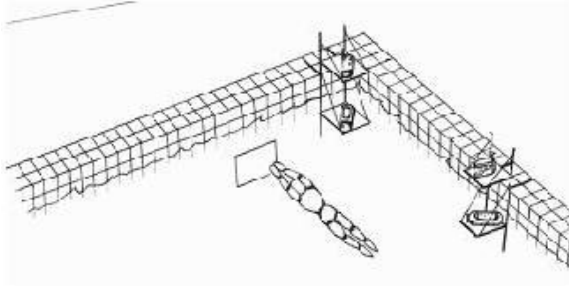
Figura 1. Localização e orientação das câmeras e dos suportes utilizados para o registro das